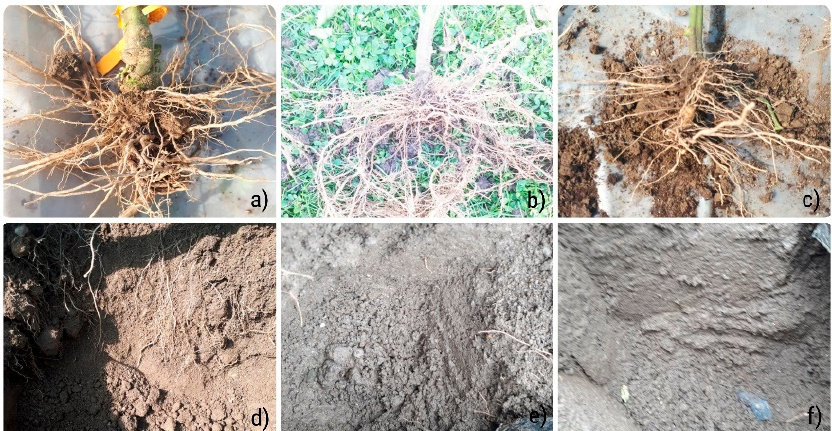
Figure 1. Differences induced by treatments in fresh tomato plant roots: ( a ) roots treated with mycorrhiza; ( b ) fertilized roots; ( c ) control roots (with no treatment). Soil profile containing thin roots after the extraction of plant; ( d ) soil of mycorrhizal treatment; ( e ) fertilized soil and ( f ) control soil (without treatments).